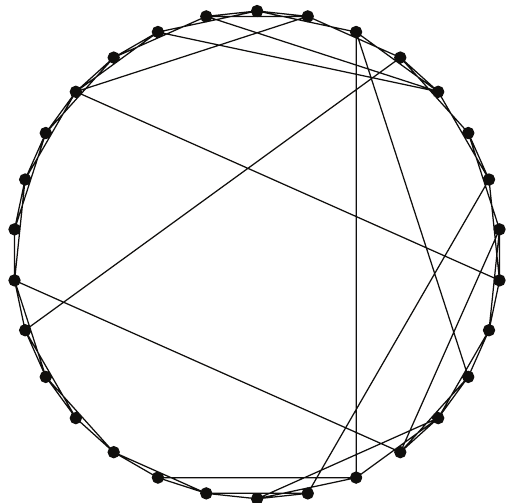
Figure 7: The structure of WS small-world network with 𝑁 = 30, 𝐾 = 4 , and 𝑝 = 0.2 .